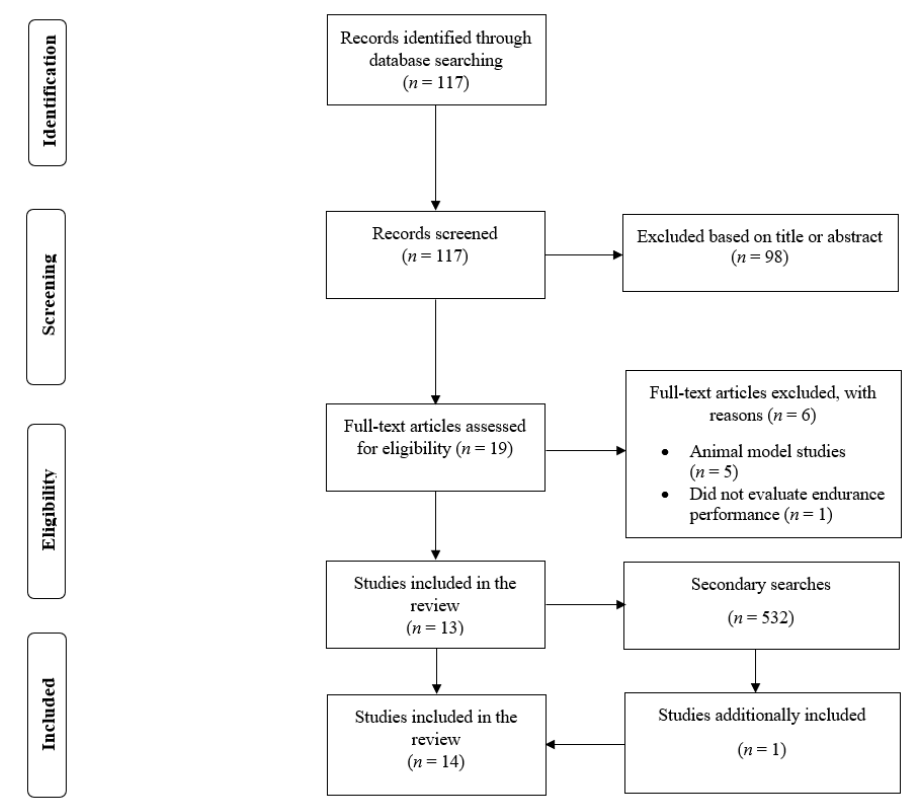
Figure 1. Flow diagram of the search